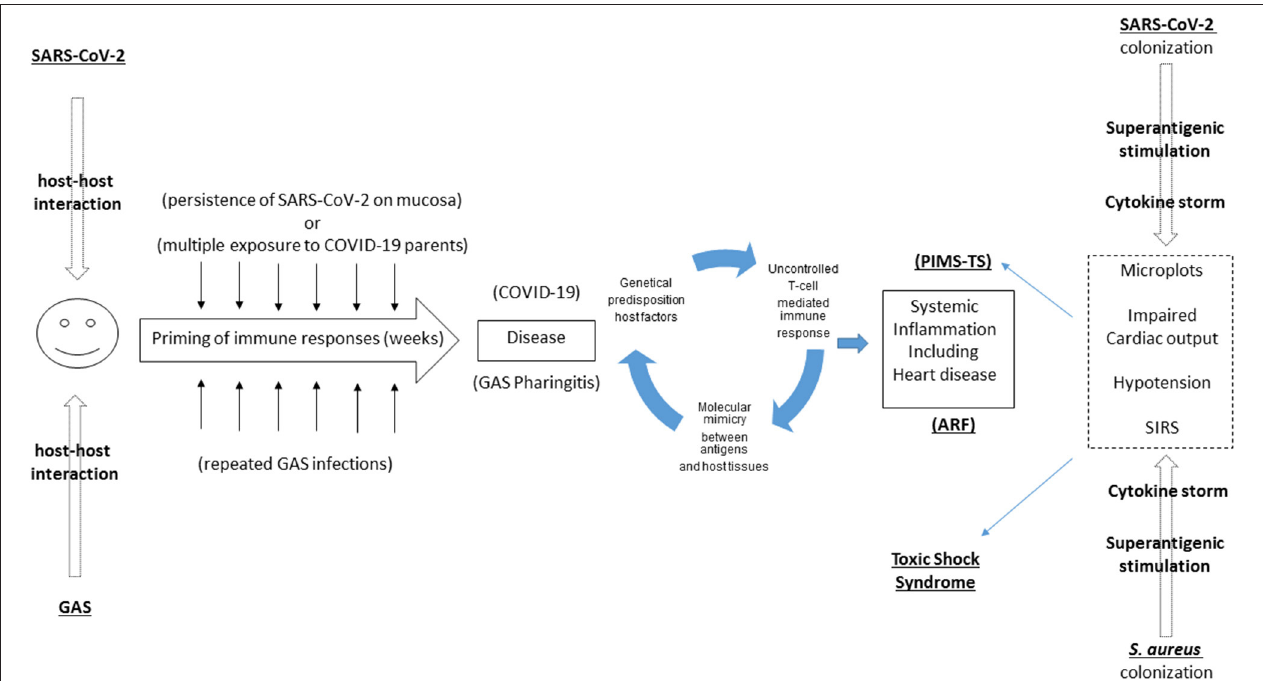
FIGURE 1 | Overlaps between Pediatric Inflammatory Multisystem Syndrome temporally related with COVID-19” (PIMS-TS), Acute Rheumatic Fever (ARF), and Toxic Shock Syndrome. PIMS-TS and ARF share the delay between first infection and the subsequent development of a systemic disease. While a molecular mimicry mechanism has been documented in ARF, this is still unproven in PIMS-TS. PIMS-TS and TSS share the sudden and strong immunological storm triggered by a superantigen, recently described in SARS-CoV-2 as